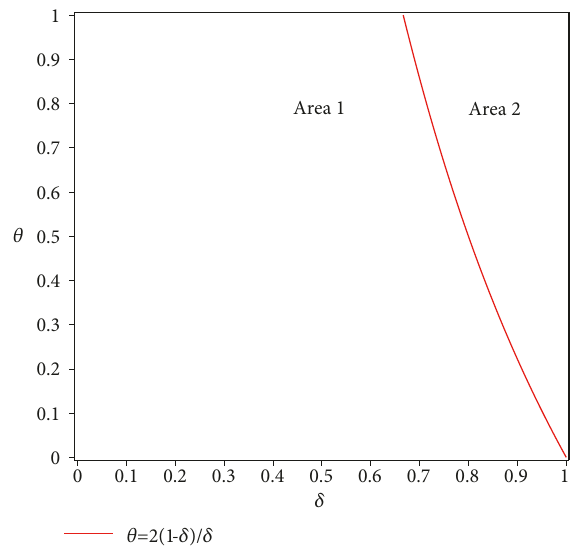
Figure 2: Second-period pricing strategy with condition under cost reduction. Note. Area 1, 𝜃 < 2(1 − 𝛿)/𝛿 ; Area 2, 𝜃 > 2(1 − 𝛿)/𝛿